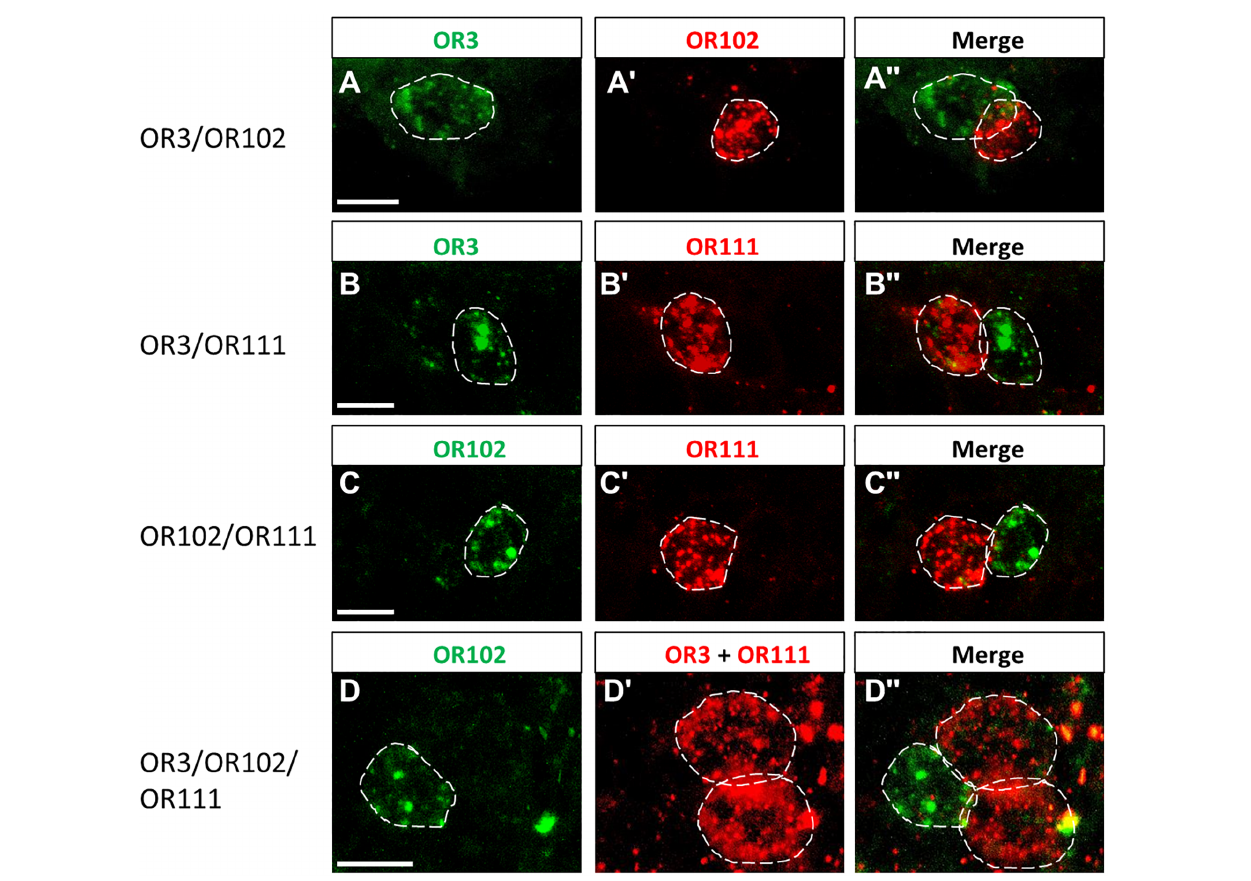
FIGURE 5 | Cells expressing distinct OR types are adjacently located in the trichoid sensilla. (A–D”) The relative position of cells in the trichoid sensilla which express distinct OR types was visualized by means of two-color FISH using specific antisense riboprobes labeled in DIG (red fluorescence) or Bio (green fluorescence). White dash circles outline the position of cells expressing a distinct OR type. Note in panel D two red-labeled cells were visualized due to the usage DIG-labeled riboprobes for both OR3 and OR111. Scale bar, 10 µ